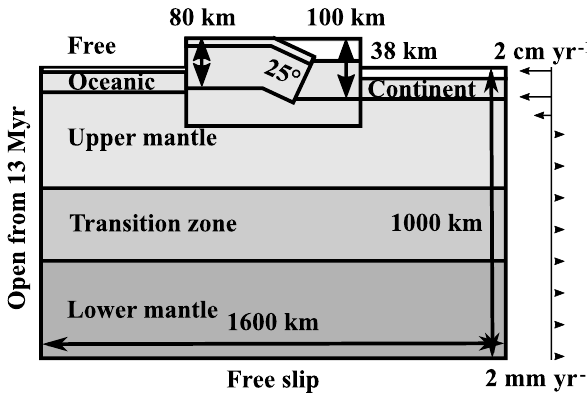
Figure B1. Compressible subduction model setup: subduction of an oceanic plate of 80km thickness underneath a 100km thick conti- nental plate is initiated with an 80km slab. Different compositional fields are used to describe the oceanic and continental crusts and the upper mantle (UM), transition zone (TZ), and lower mantle (LM) material. A 2-times viscosity increase is also included at the 660km phase boundary. The top boundary is a true free surface; the right vertical boundary has a prescribed in- and outflow as indicated from 8Myr onward. A similar flow (4cmyr − 1 inflow) is prescribed on the left boundary until 13Myr, when the boundary is